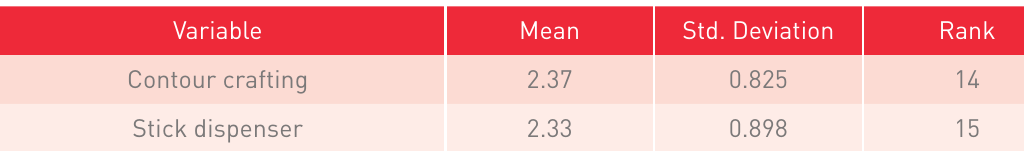
Variable Mean Std. Deviation Contour crafting